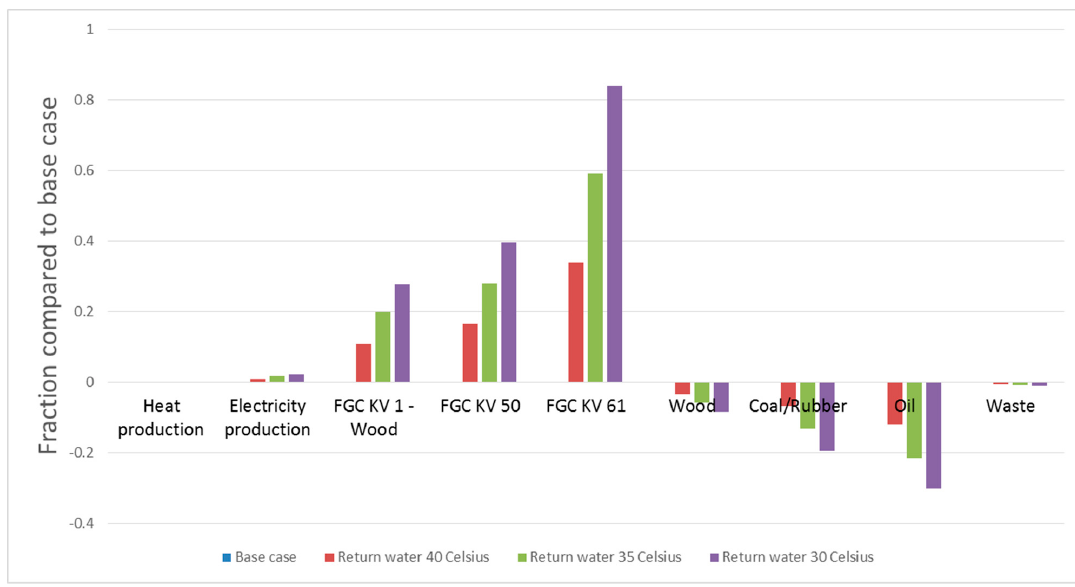
Figure 11. Modelled changes in whole year e ffi ciencies and fuel consumption.